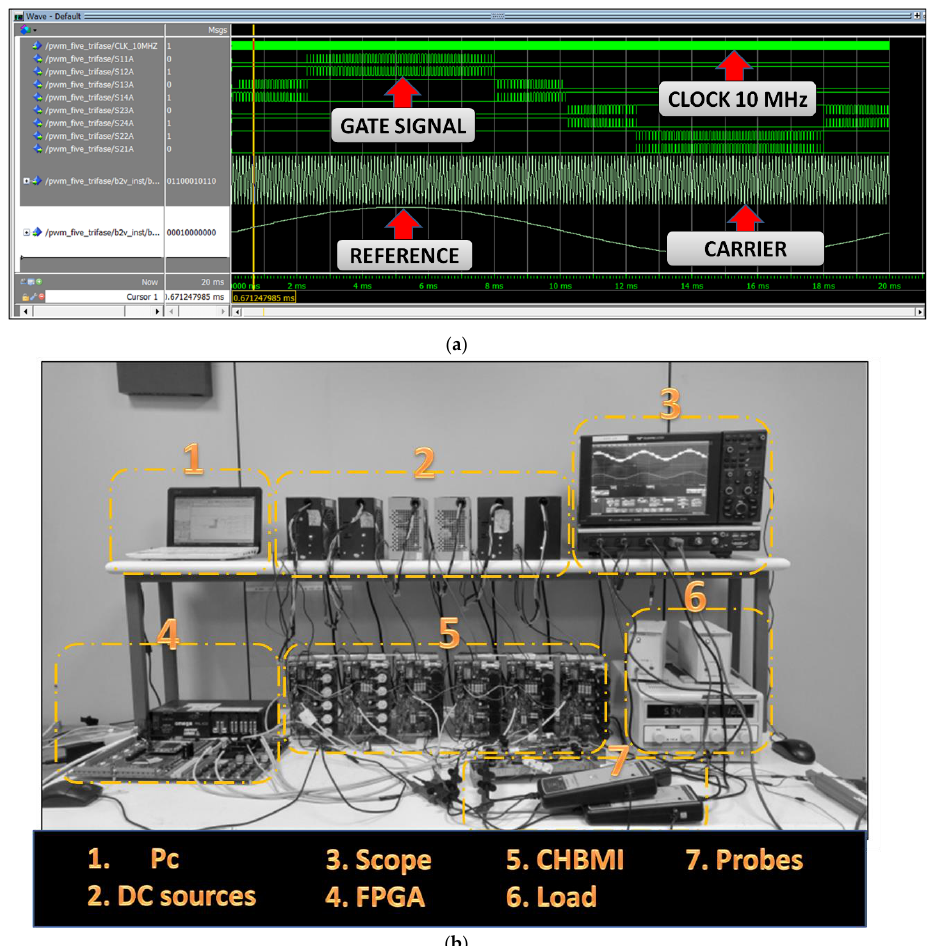
Figure 8. Experimental implementation: ( a ) Gate level simulation results and ( b ) a photograph of the test bench.